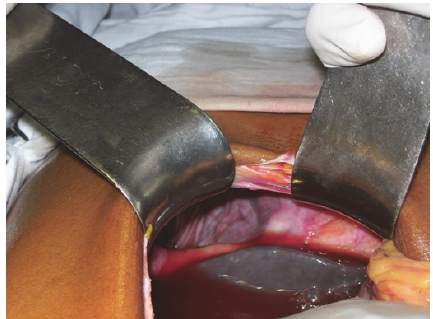
Figure 3: Intraoperative photo showing the inflammatory haemor- rhagic fluid around the diaphragmatic defect.